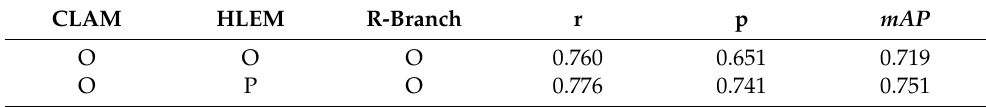
Table 12. Effectiveness of HLEM when the other two modules are not added.